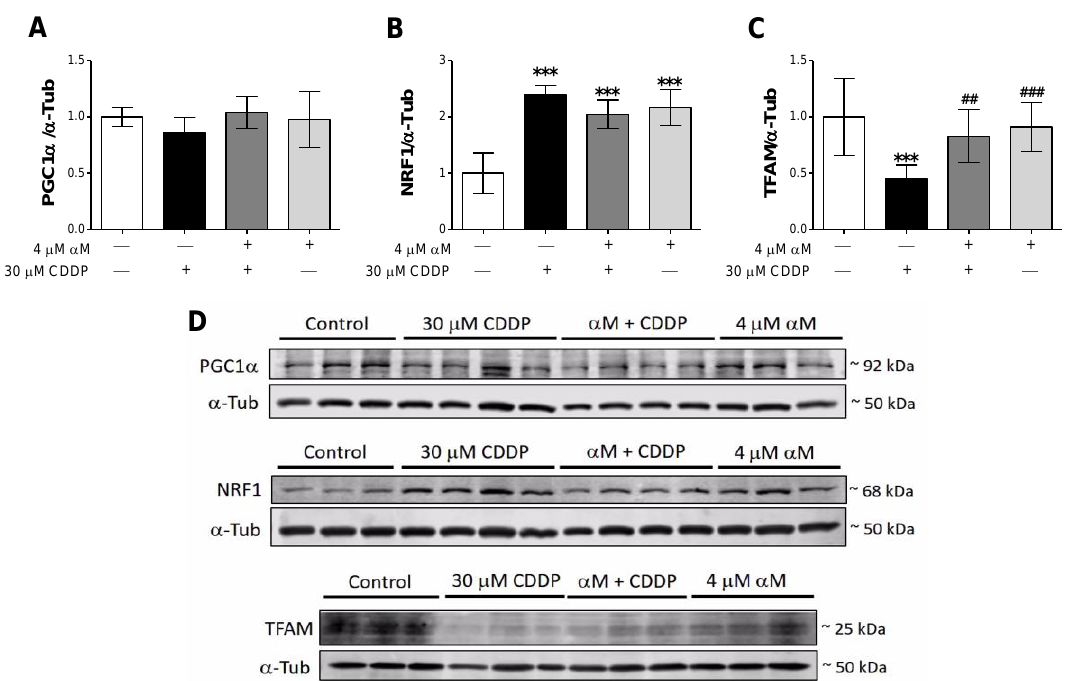
Figure 7. Modulation of mitochondrial biogenesis in LLC-PK1 cells treated with α M, CDDP or both. After 24 h of treatment, protein levels of ( A ) peroxisome proliferator-activated receptor gamma (PPAR γ ) coactivator 1-alpha (PGC1 α ), ( B ) nuclear respiratory factor 1 (NRF1), ( C ) mitochondrial transcription factor A (TFAM) were quantified. Representative blots are shown in ( D ). The data are presented as mean ± SD, n = 5–7. *** p < 0.001. ### p < 0.001 and ## p < 0.01 vs. CDDP. α -Tub =